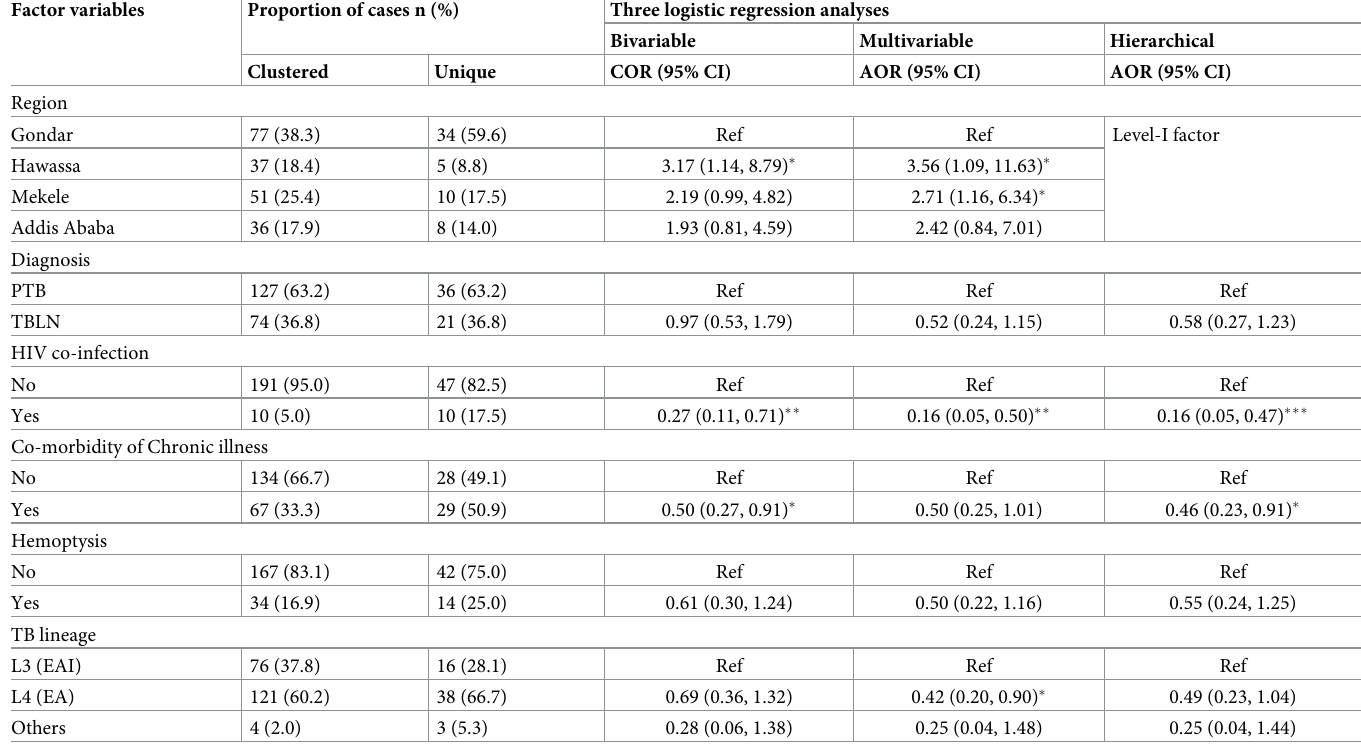
Table 4. Conventional and hierarchical (multi-level) logistic regression modeling methods were used to identify factors associated with strain clustering based on